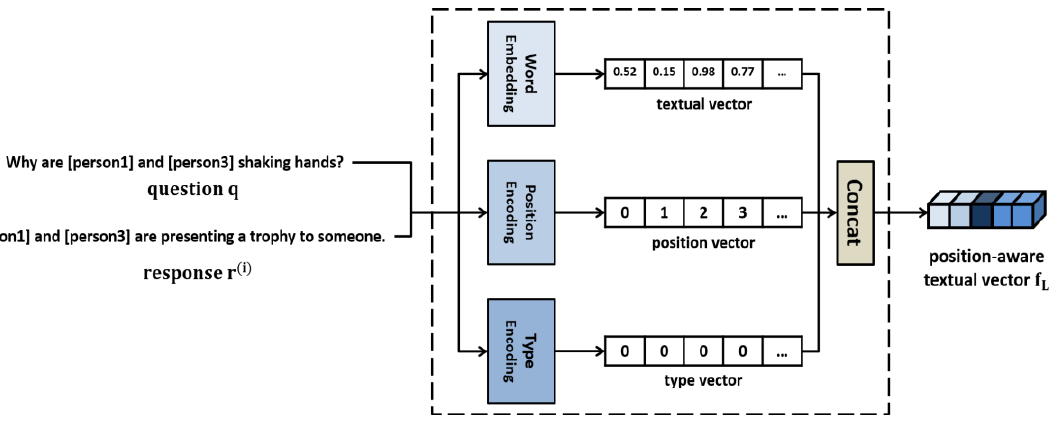
Figure 6. Text embedder.